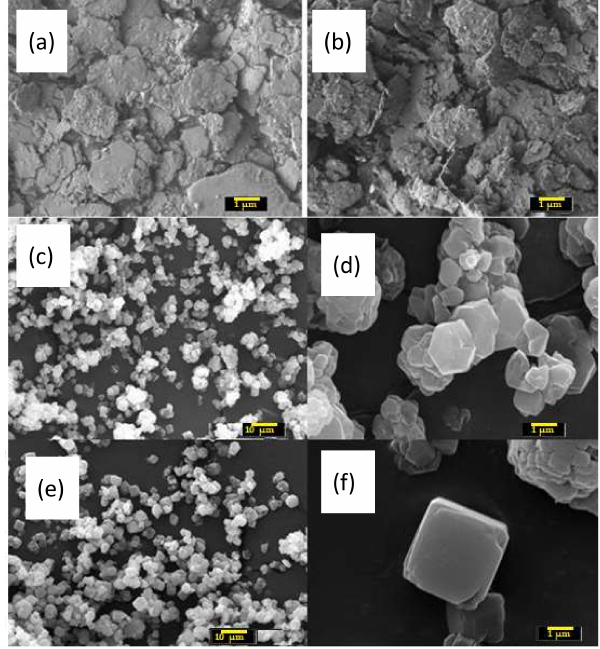
Figure 4. SEM micrographs of purified white kaolin ( a ) and red kaolin ( b ), Zeo zeolite ( c , d ) and Zeo-R zeolite ( e , f